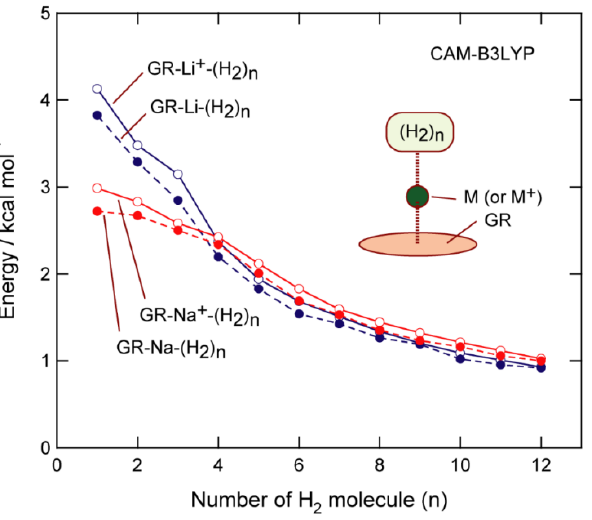
Figure 6. CAM-B3LYP/6-311G(d,p)-calculated H 2 – GR-M binding energies (per H 2 molecule) plot- ted as functions of n (M = Li, Li + , Na, and Na + ). as functions of n (M = Li, Li + , Na, and Na +